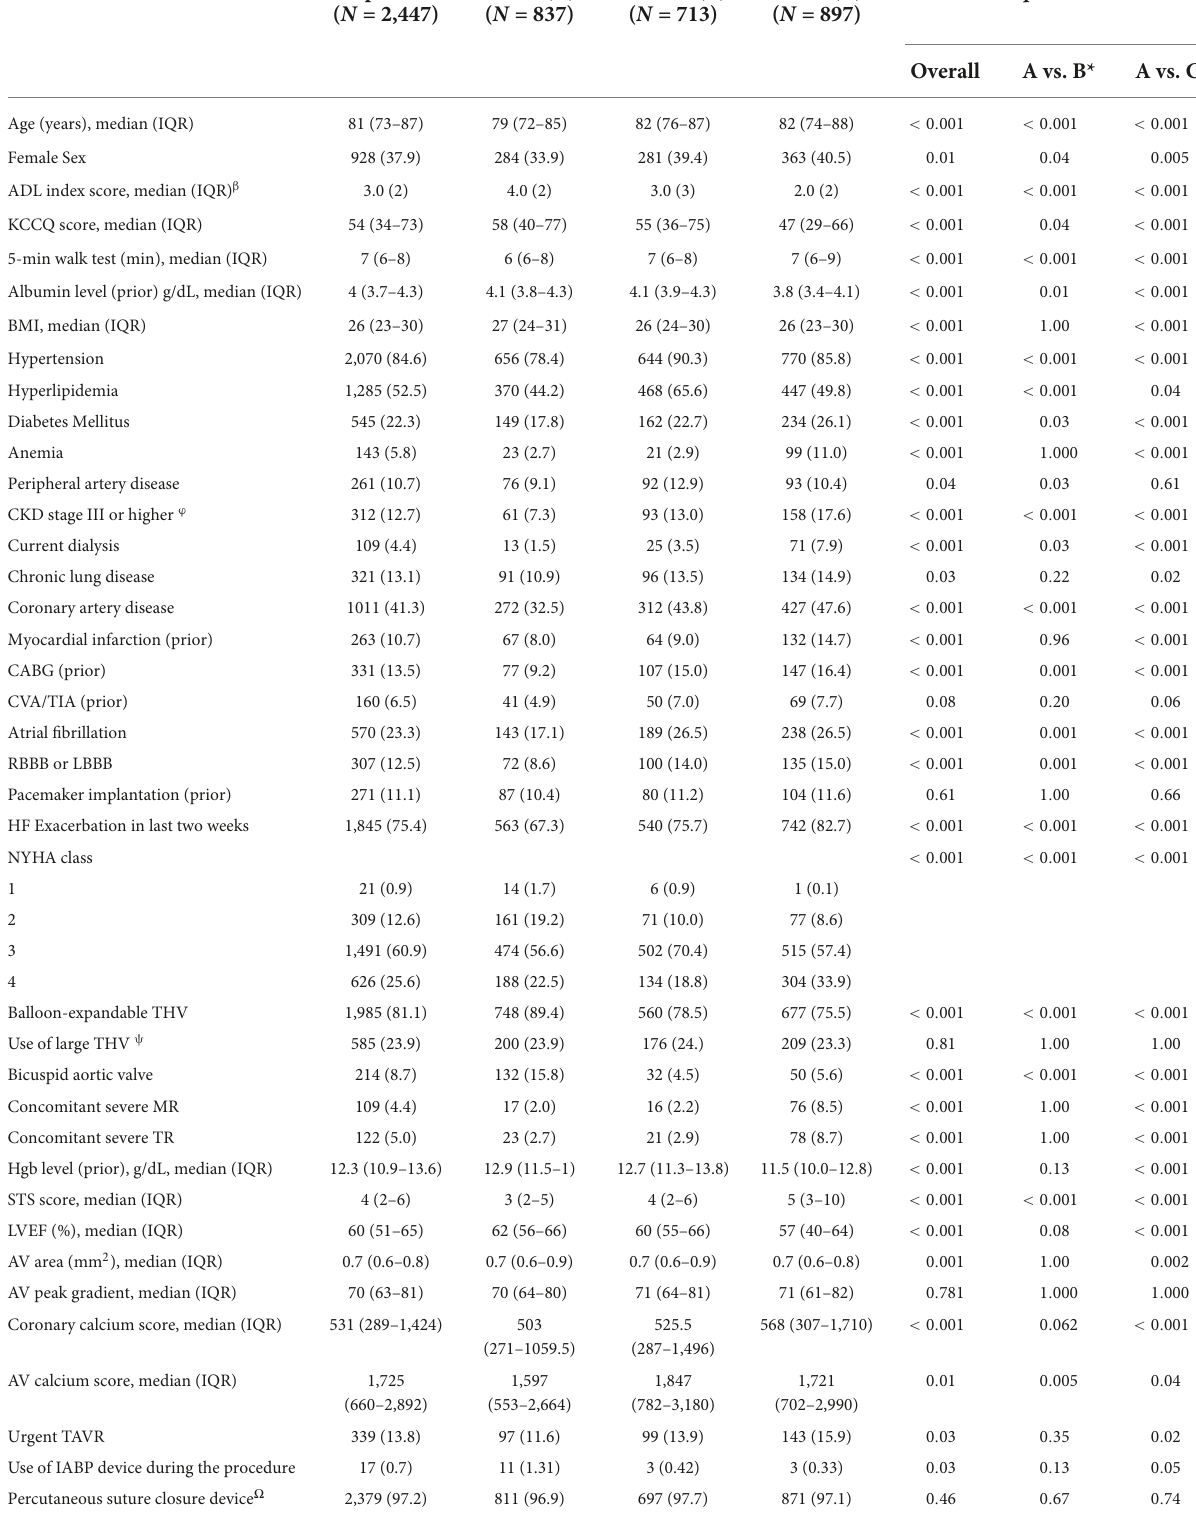
TABLE 1 Patient characteristics stratified by discharge